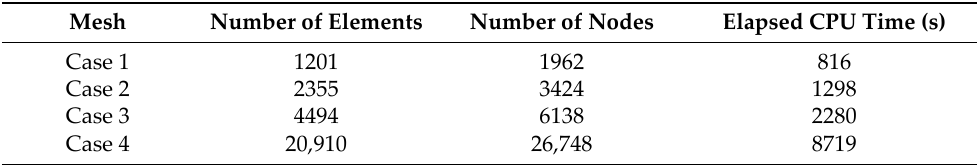
( c ) Figure 7. Mesh of the solid FEM model: ( a ) The mesh of the bolt-jointed beam; ( b ) The local mesh of the steel beams; ( c ) The mesh of the bolt, nut and spacers. Table 3. Analysis cases for each mesh density. Mesh